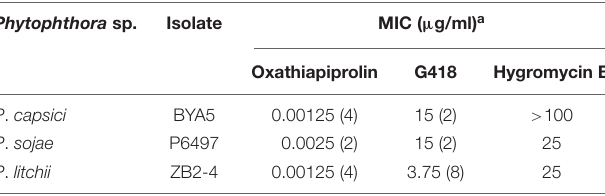
TABLE 1 | MICs determination of oxathiapiprolin and two antibiotics to three Phytophthora spp. Phytophthora